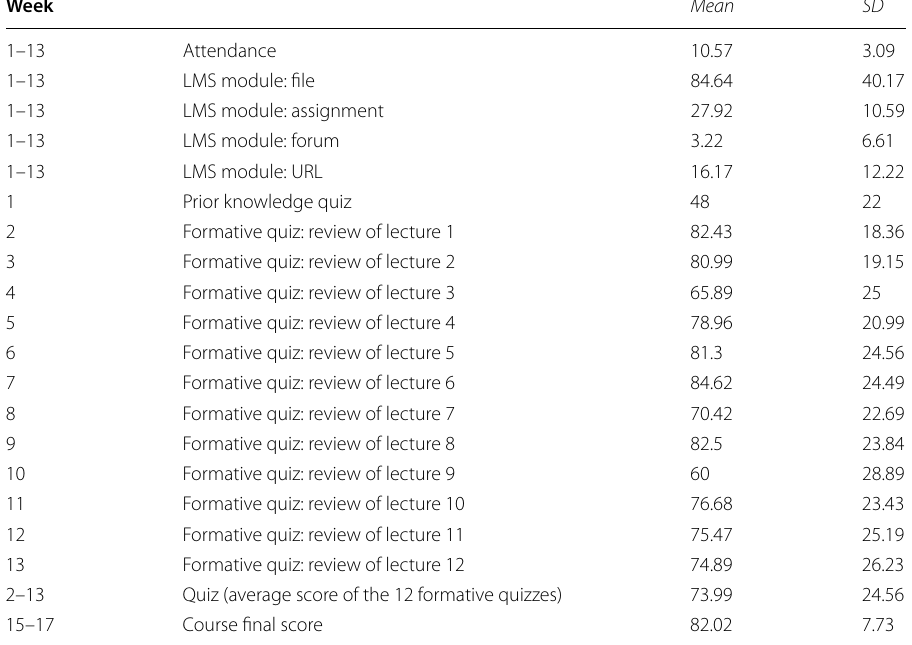
Table 1 Descriptive statistics of the observed